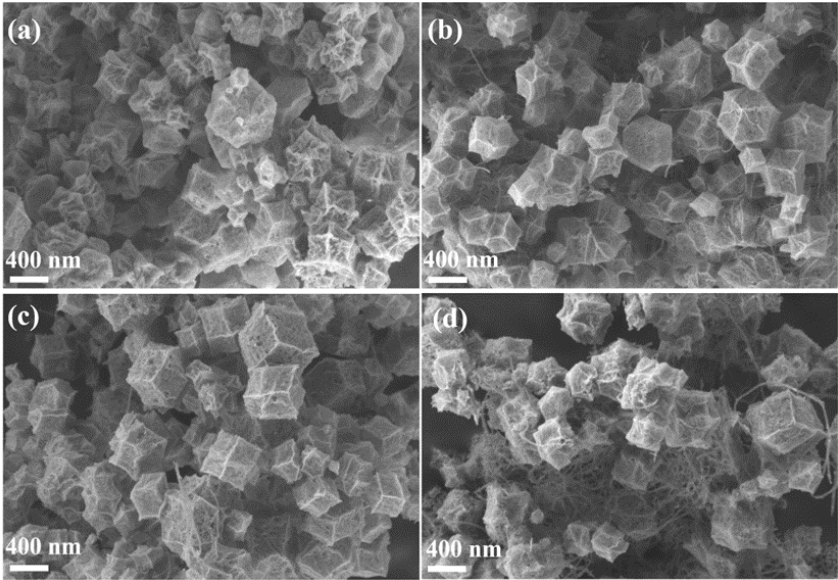
Figure 1. Different MWCNT additions, MWCNTx@Co 3 O 4 . SEM diagram of nanocomposites: ( a ) MWCNT 1 @Co 3 O 4 ; ( b ) MWCNT 2 @Co 3 O 4 ; ( c ) MWCNT 3 @Co 3 O 4 ; ( d ) MWCNT 4 @Co 3 O 4 .